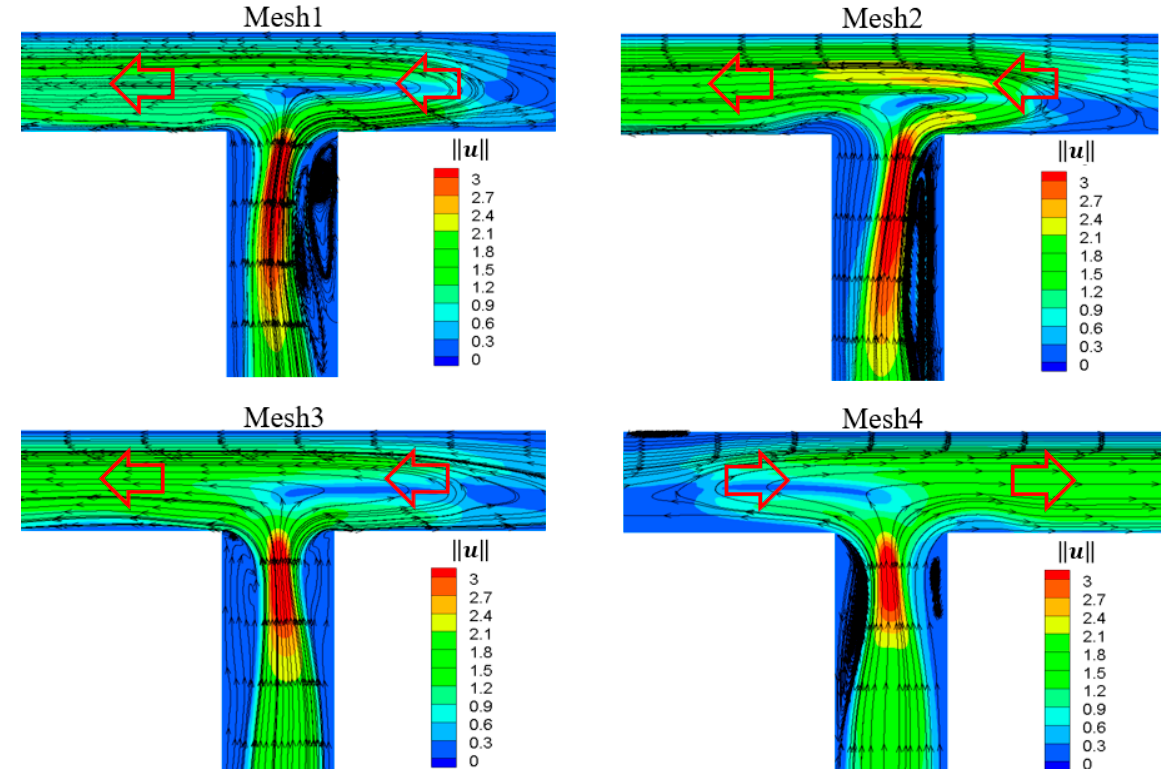
connected by dotted line.